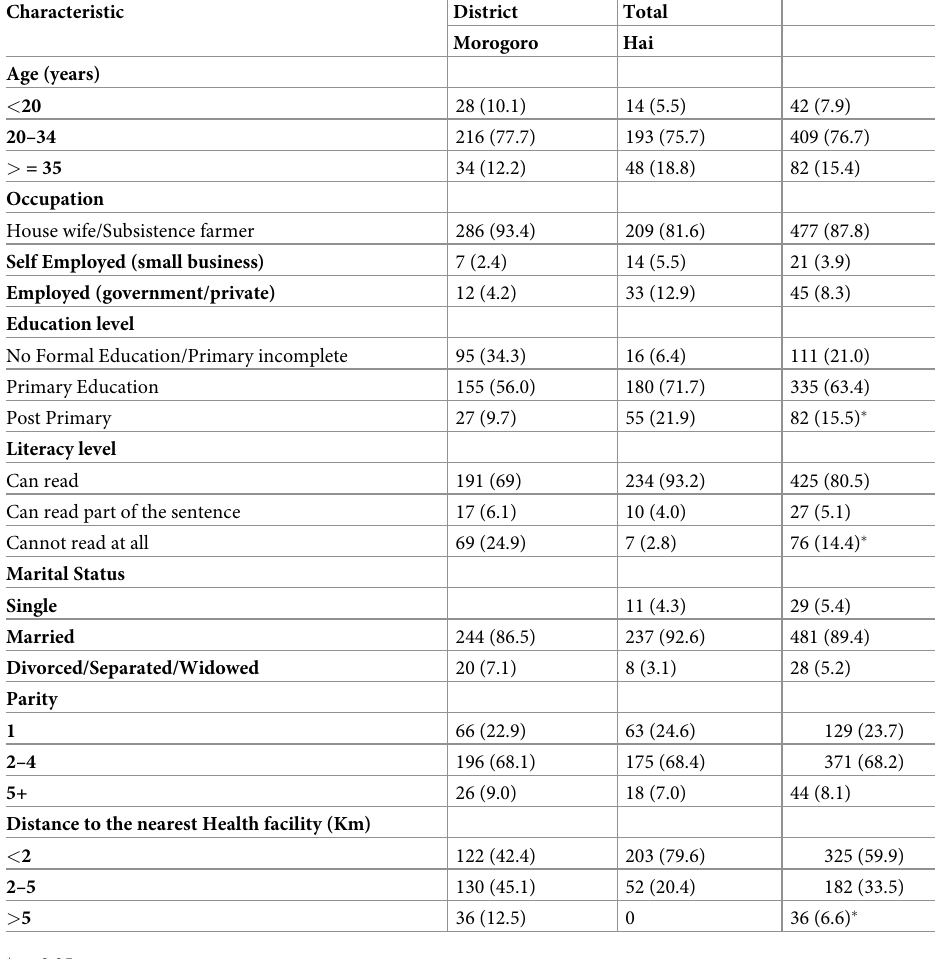
Table 1. Socio demographic characteristics of the study participants by